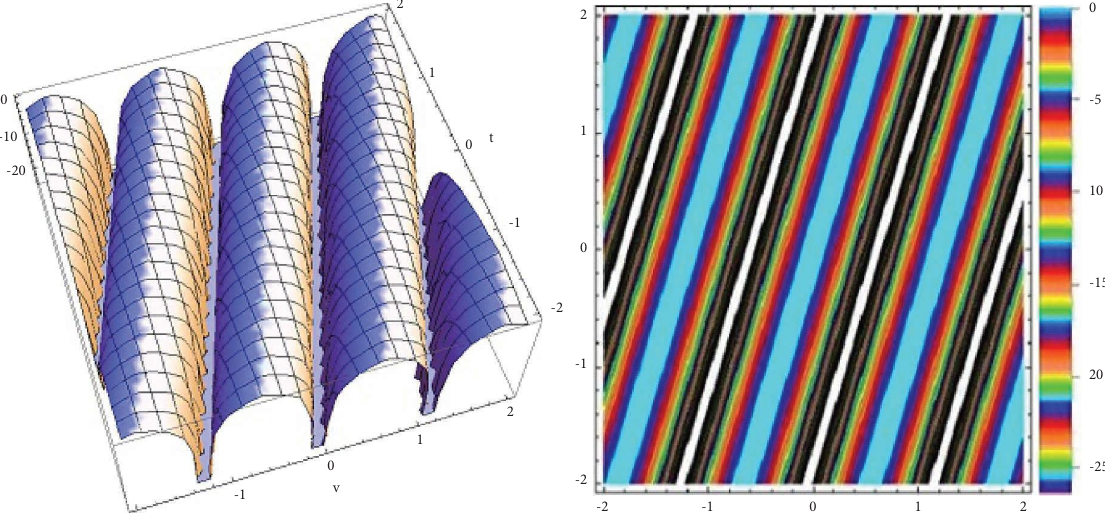
Figure 2: Sketched the singular periodic soliton from (11) when ω � 3 .